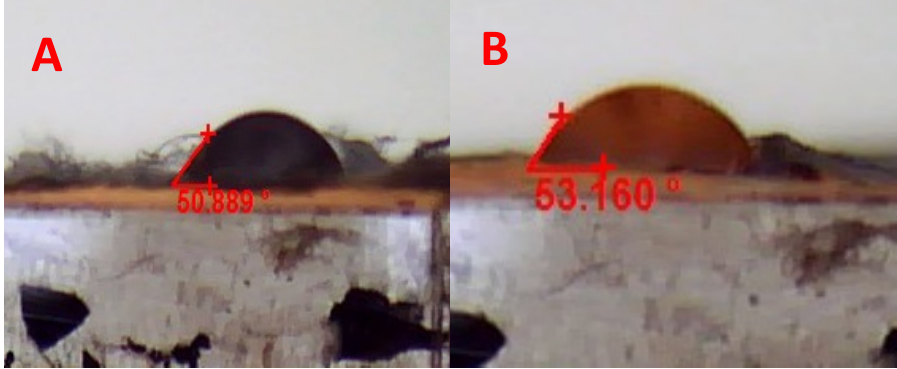
Figure 7. Water contact measurement of ( A ) SF-CS-Ag-CUR (CS 7% w / v ) and ( B ) SF-CS-Ag-CUR (CS 9% w / v ).